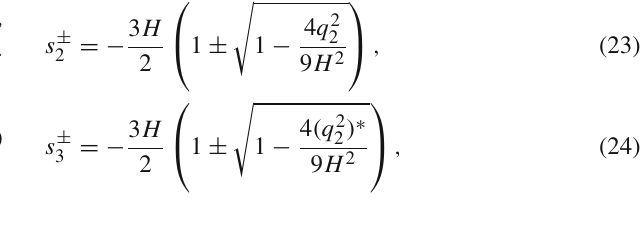
where q 2 is the pole (10) of Minkowski spacetime. Damped (growing) modes have negative (positive) real part, thus for the renormalization scale (11) s + s + and s are exponentially growing, showing that de Sitter 2 3 spacetime is also unstable in quantum